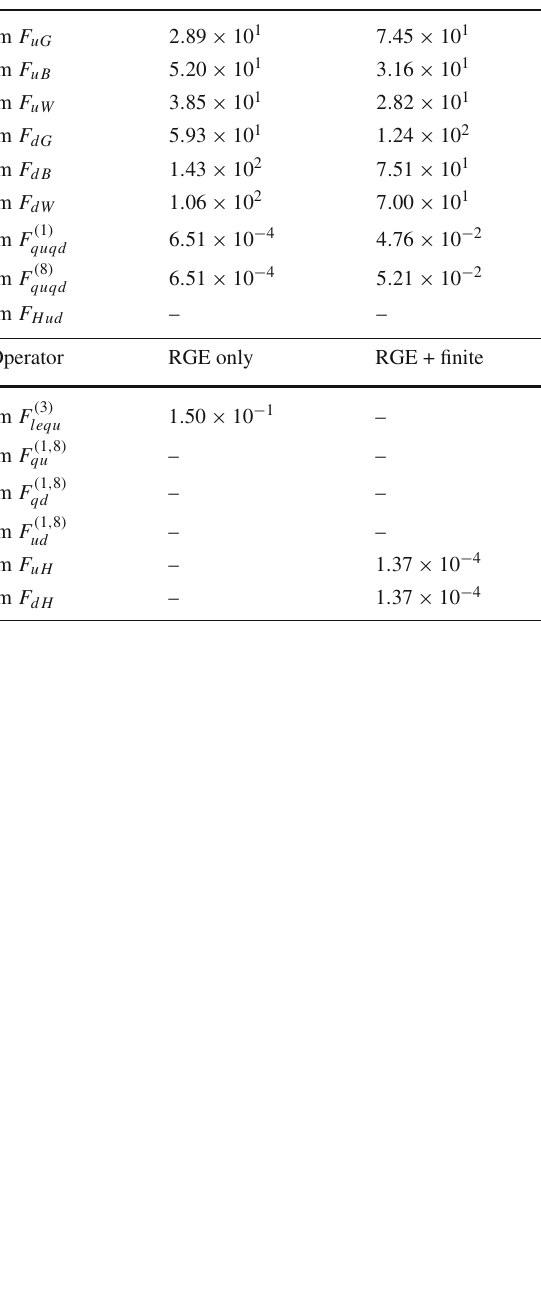
Table 14 Upper bounds on the Wilson coefficients assuming (cid:2) = 5 TeV and a U ( 2 ) 5 flavor symmetry, keeping terms up to O ((cid:16), V 2 ) . We use the notation of Ref. [92] for the Wilson coefficients (see also Appendix C). The operators O Hud and O